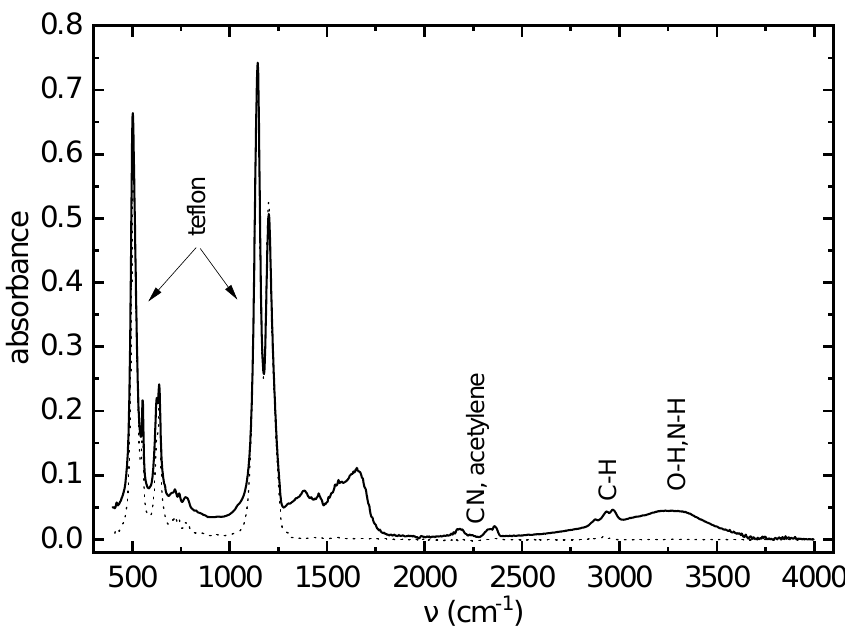
Figure 2. FTIR spectrum of PB thin film deposited at the monomer flow rate of 65 sccm (full line) and FTIR spectrum of bare teflon (dotted